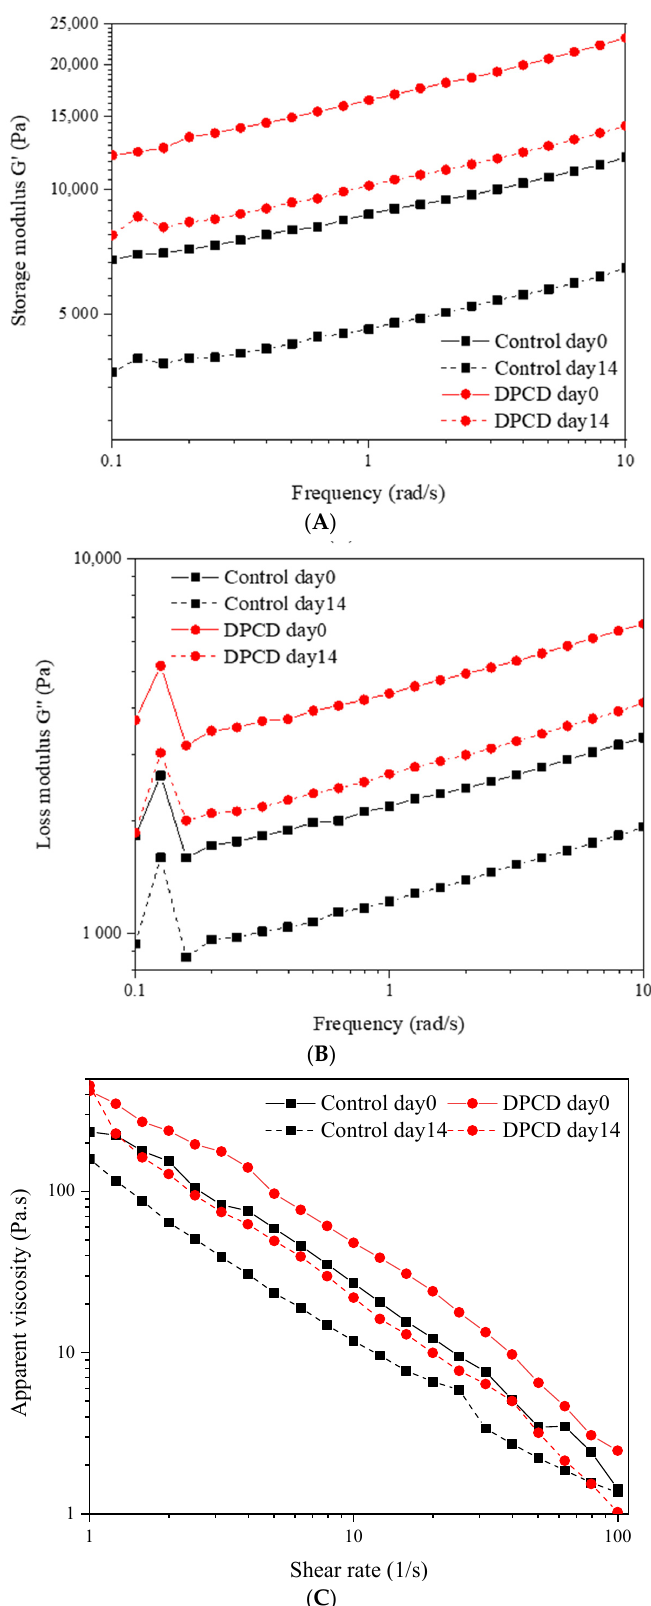
Figure 2. Storage modulus (G ′ ) ( A ), loss modulus (G ″ ) ( B ) and apparent viscosity ( C ) of control and dense-phase carbon dioxide (DPCD)-processed quark cheese stored at 4 °C.